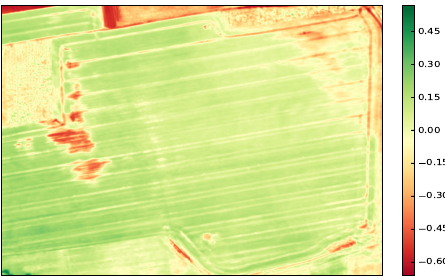
Figure 12: NDVI map generated with the solutions presented in the pa- per. The area is about 550 m × 550 m and was captured during three sequent flights (see figure 11 for corresponding RGB